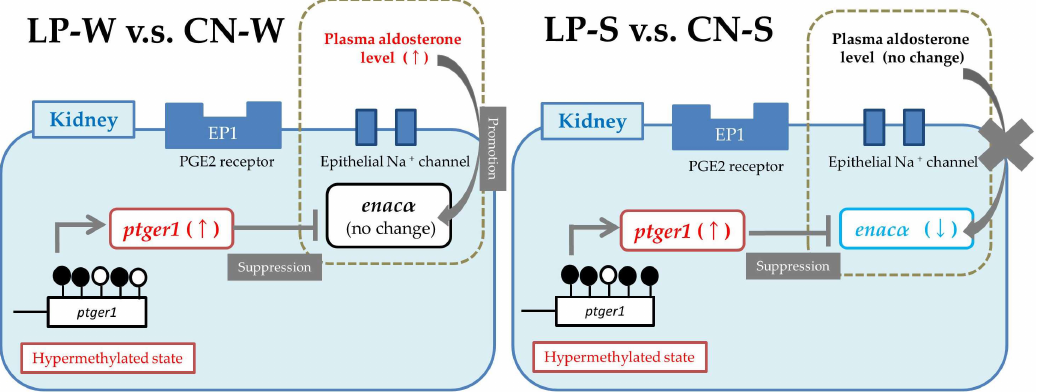
Figure 5. Schematic diagram showing the hypothesized changes to renal Na + transport/homeostasis that were incurred in the Spontaneously Hypertensive Stroke Prone Rat (SHRSP) offspring by the imposed maternal protein restriction.